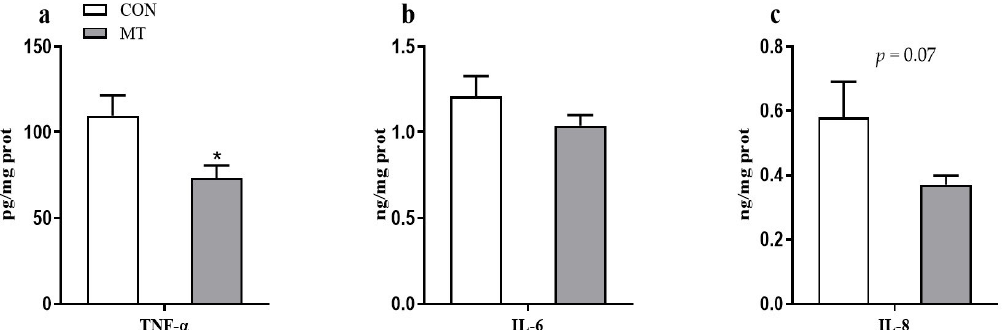
Figure 7. Effects of maternal MT supplementation during gestation on inflammatory cytokine in placenta. ( a ) TNF- α concentration. ( b ) IL-6 concentration. ( c ) IL-8 concentration. Data are presented as means ± SEM, n = 8. * p < 0.05. CON = control, MT = melatonin.